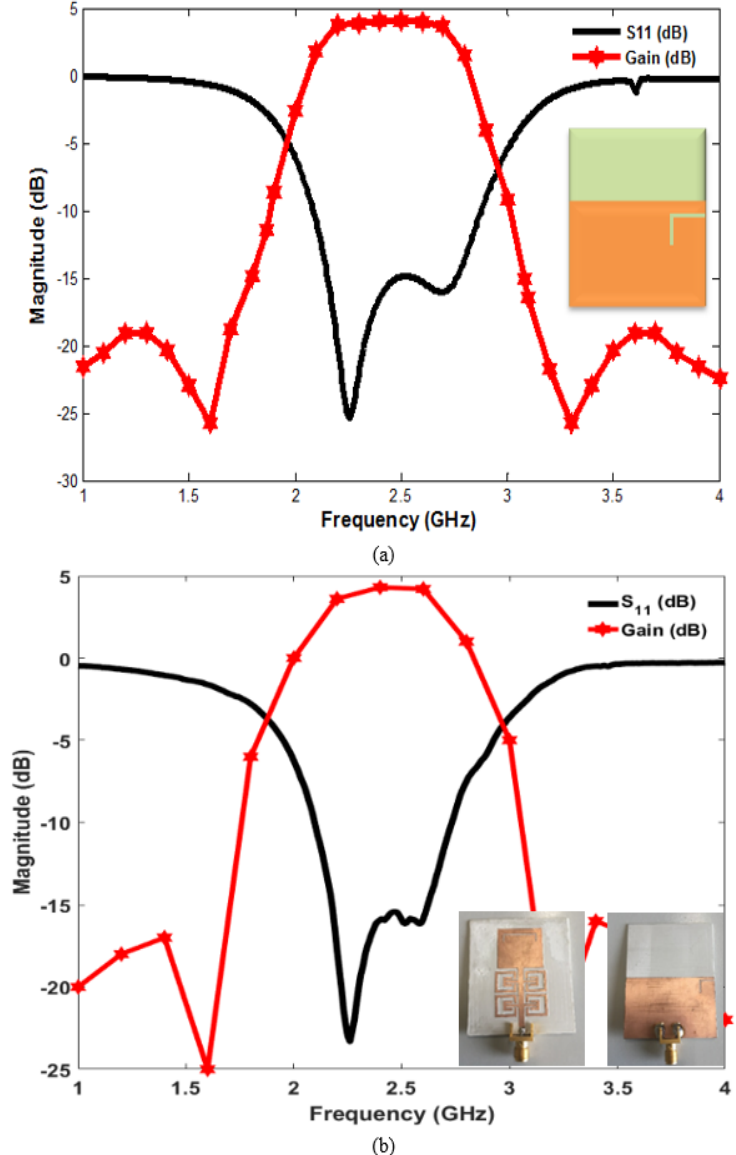
Figure 10. The performance of the proposed filter-antenna design: ( a ) simulated performance, ( b ) measured performance with a photograph of the fabricated prototype structure.